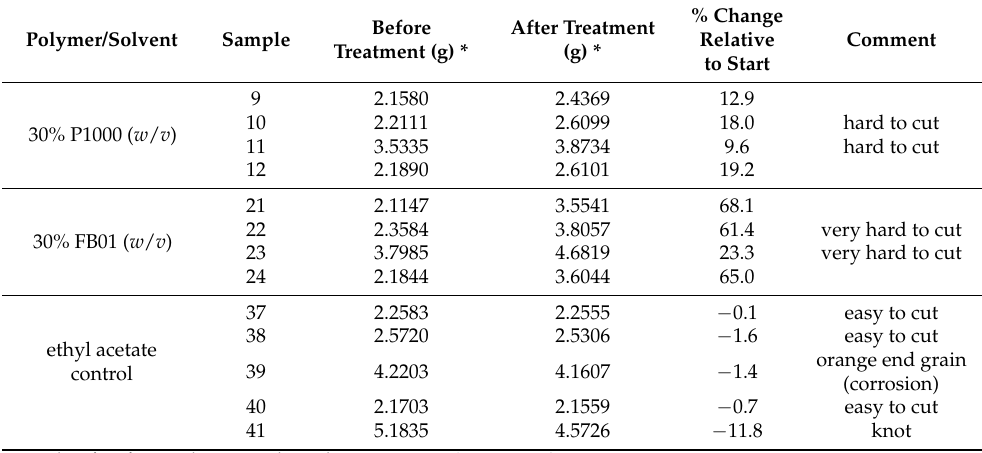
Table 6. Changes in weight relative to start